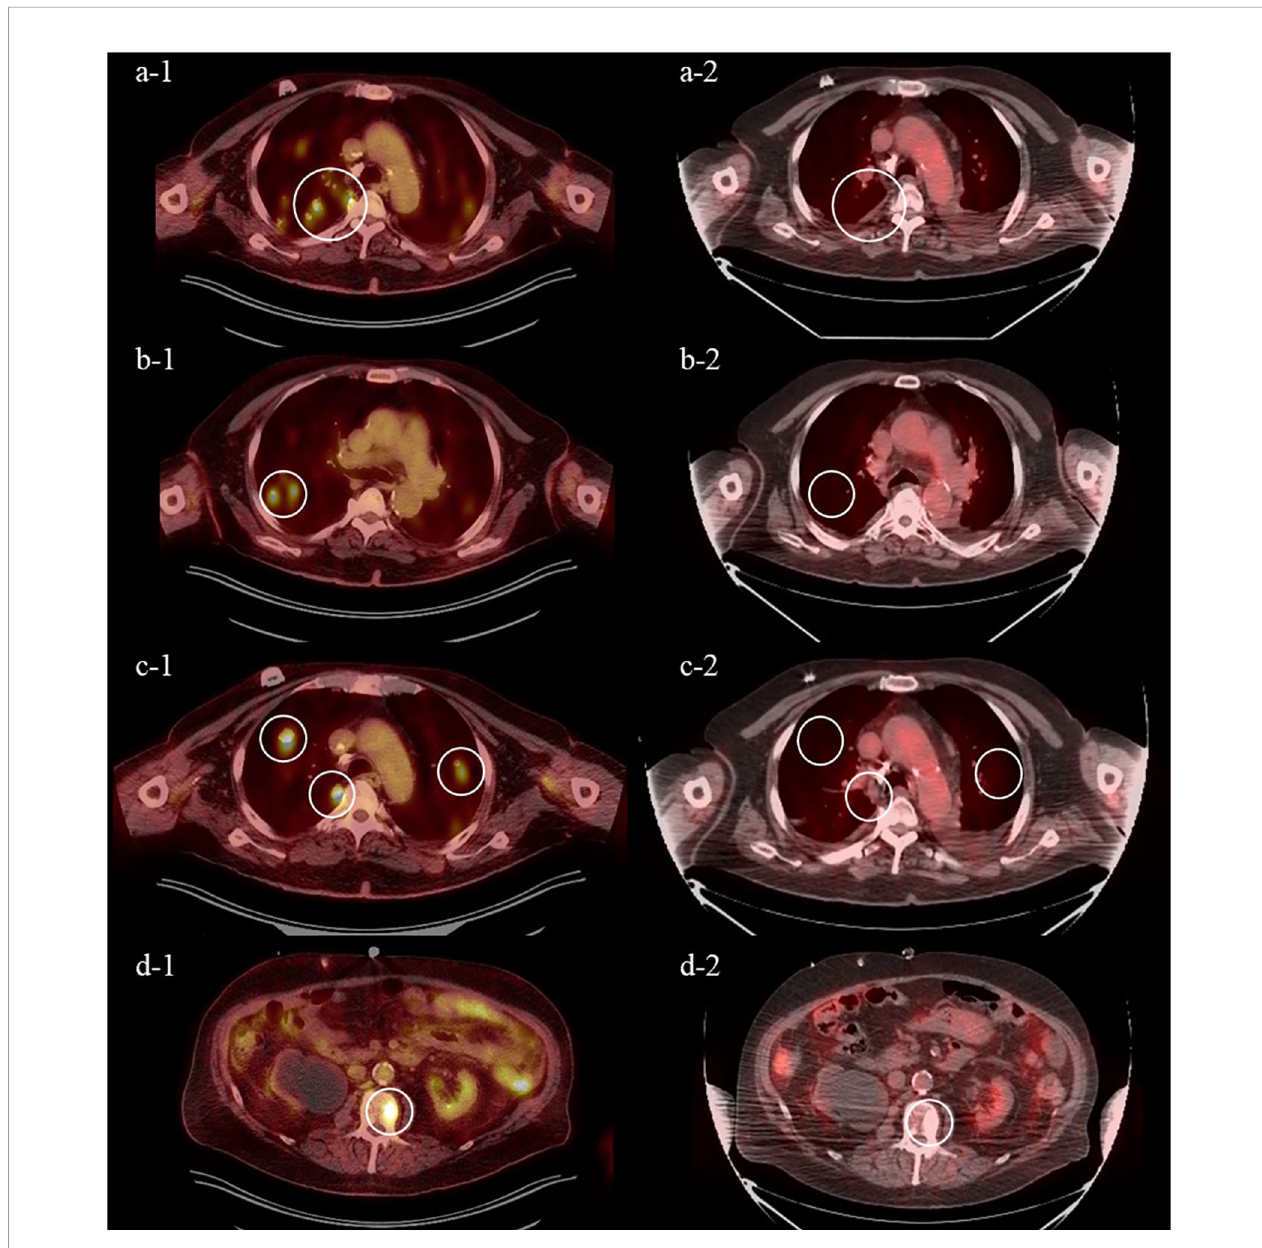
FIGURE 2 | Positron emission tomography (PET) from August 2021 after 4 cycles of pembrolizumab demonstrating increase in size and number of FDG-avid pulmonary nodules (A-1 – C-1) and FDG-avid sclerotic L2 lesion (D-1) and from November 2021 after 3 cycles of enfortumab vedotin demonstrating near complete response of FDG-avid pulmonary nodules (A-2 – C-2) and FDG-avid L2 lesion (D-2)